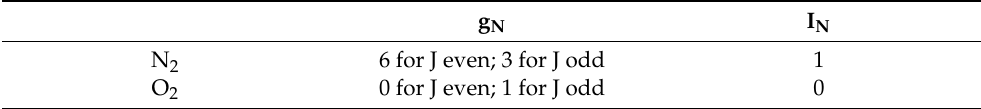
Table A1. Statistical weigh factor g N and nuclear spins I N values for N 2 and O 2 .